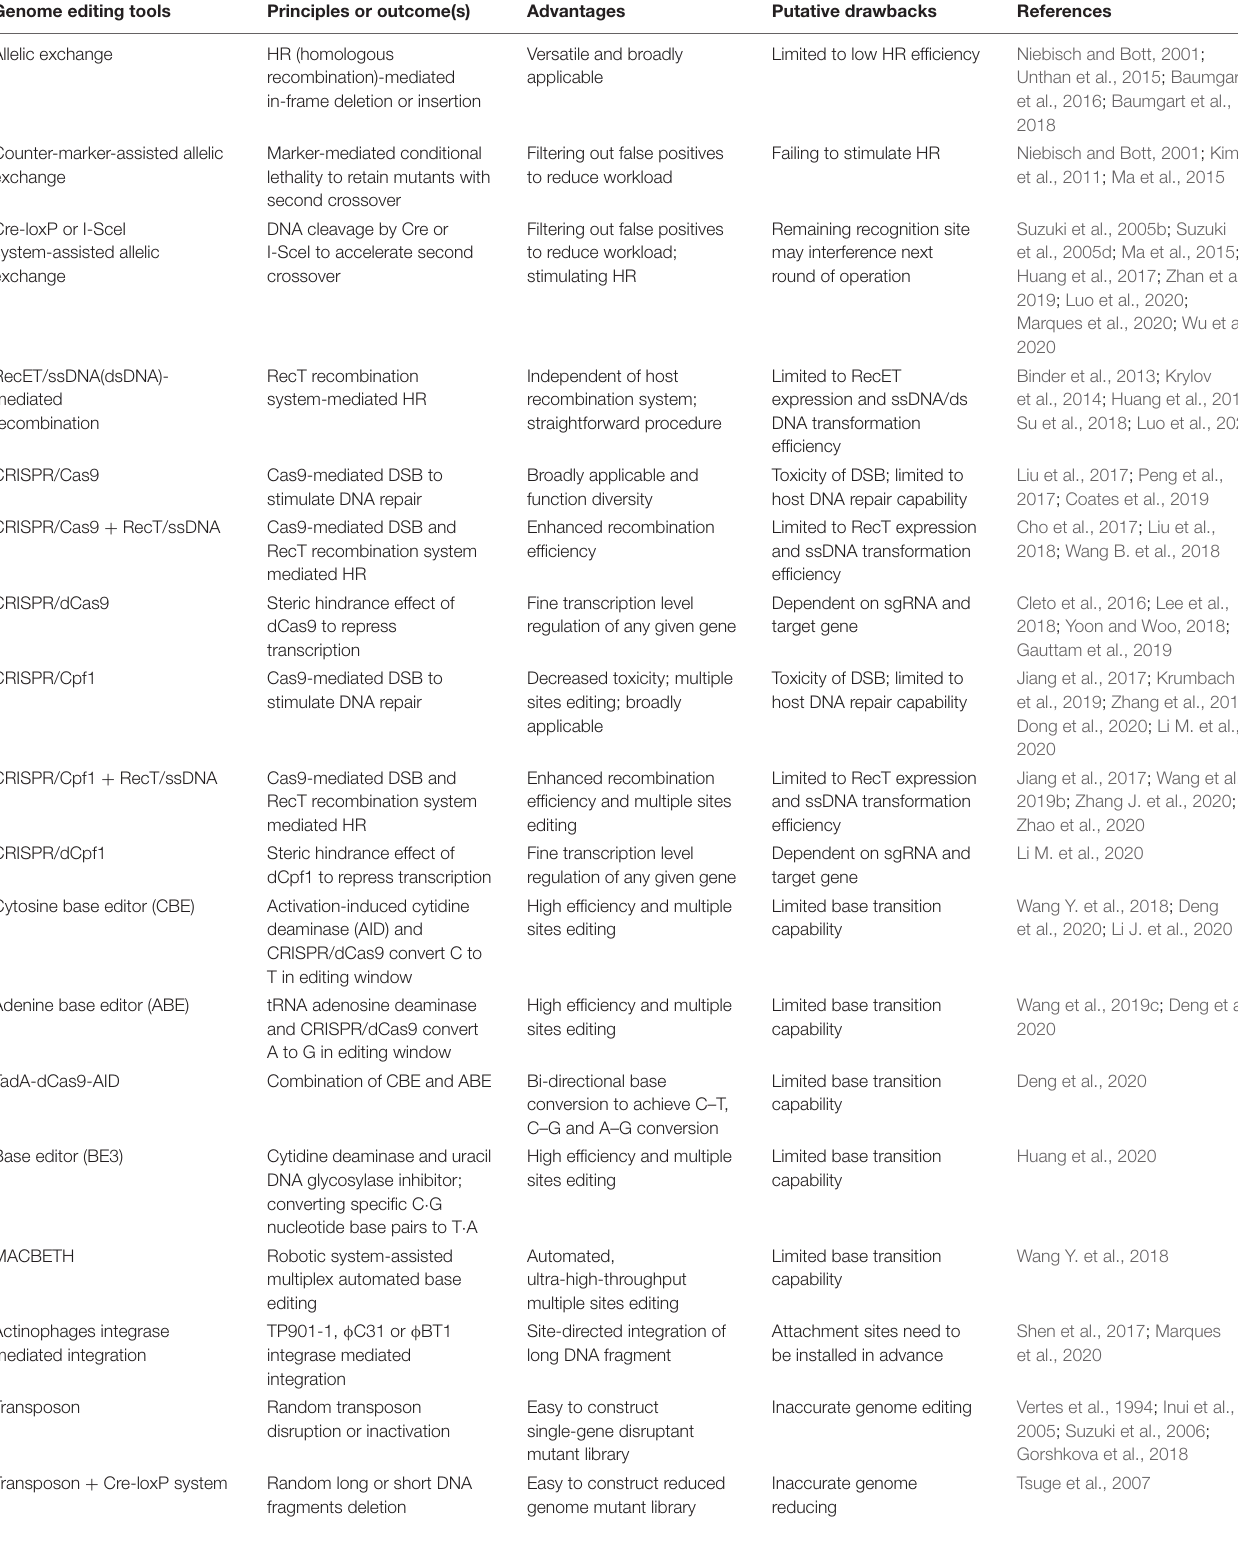
TABLE 1 | Comparison of different genetic tools applicable in C.